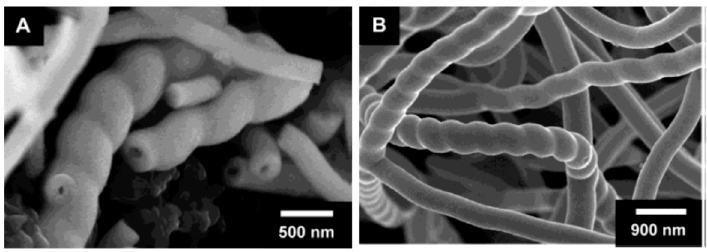
Figure 8. SEM images of tantalum oxide fibers obtained from ( A ) ( R , R ) ‐ enantiomer 31 and ( B ) ( S , S ) ‐ enantiomer 32 . Reproduced with permission from Reference [81].